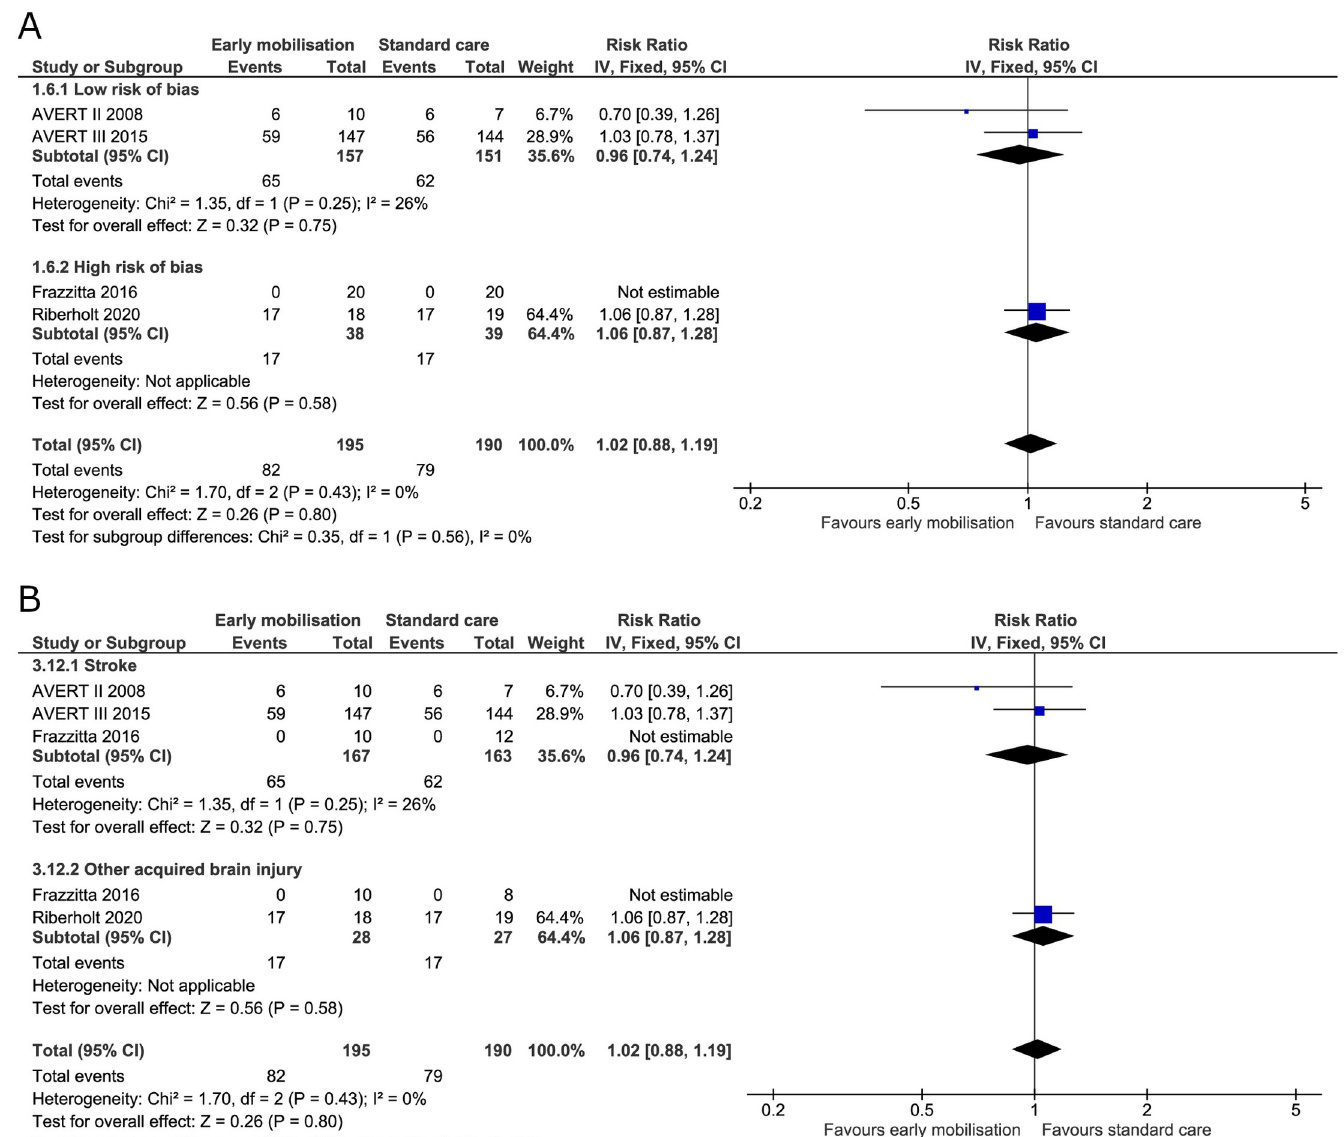
Fig 13. Comparison of early mobilisation versus standard care–Coma Recovery Scale-Revised at the end of the intervention. Fig 13A and 13B. Forest-plot showing the results from the random-effects meta-analysis of the outcome Coma Recovery Scale-Revised at the end of intervention with subgroup divided according to risk of bias (A) or diagnosis